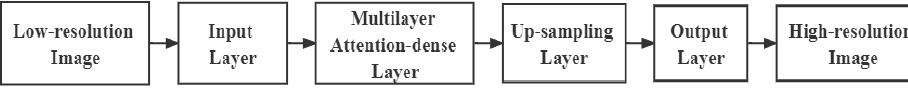
Figure 7. Examples of speckle images of engineered bamboo.